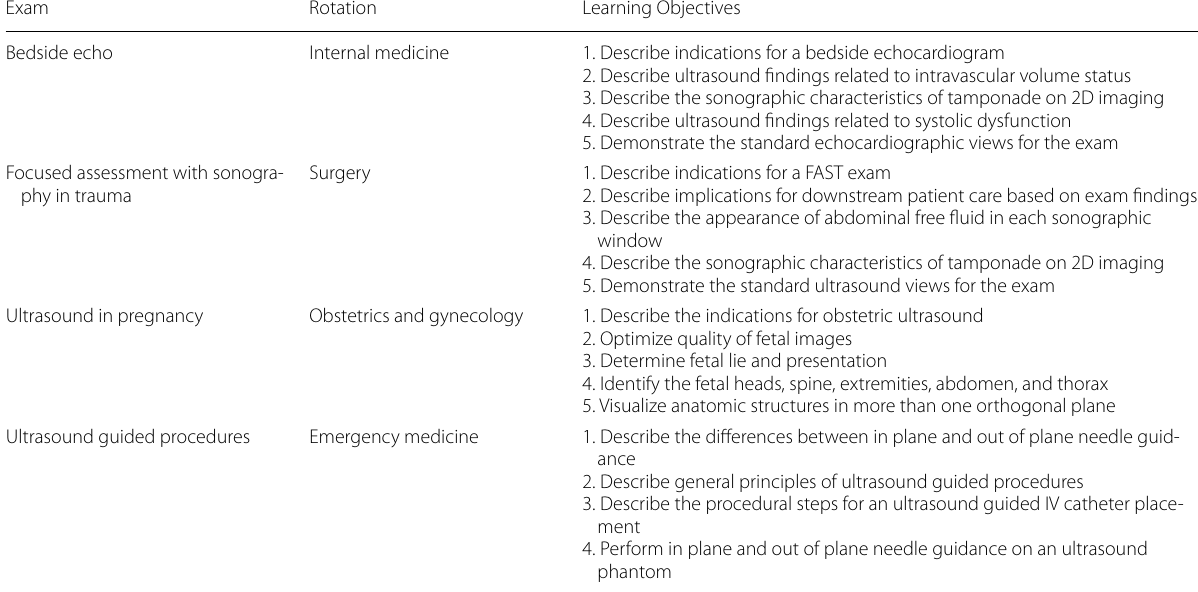
FAST focused assessment with sonography for trauma, 2D two-dimensional, IV intravenous